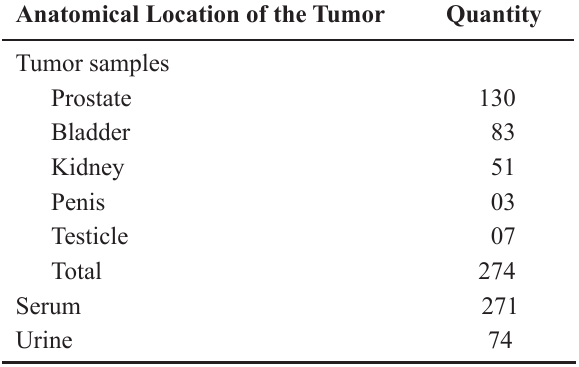
Table 2 – All material collected from the tumor bank of the Division of Clinical Urology, Oncology sector from August 2008 to June